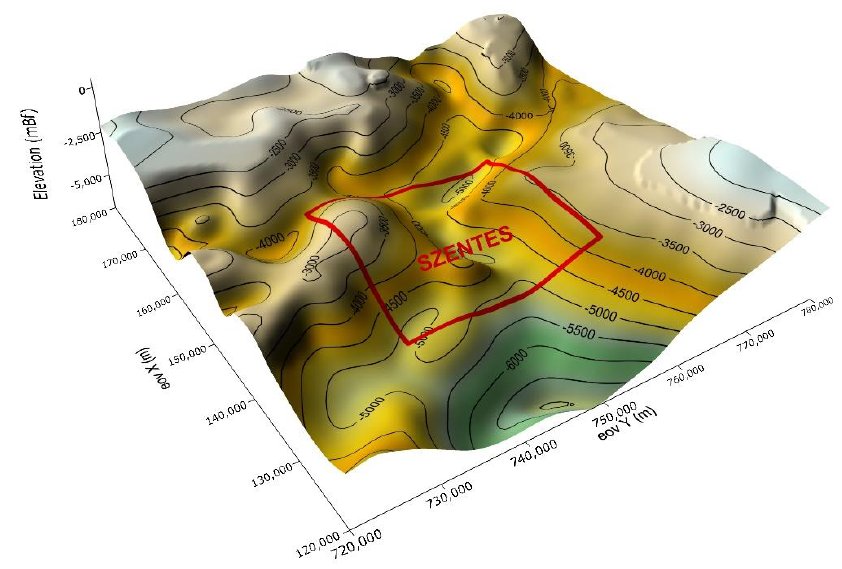
Figure 3. Depth map of Pre-Neogene basement top around Szentes study area (red rectangle) [25].